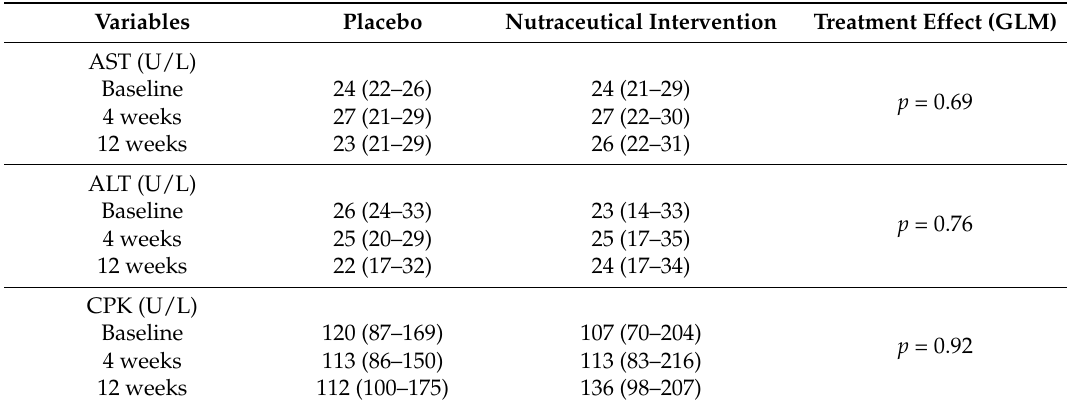
Table 3. Safety and tolerability profile of the